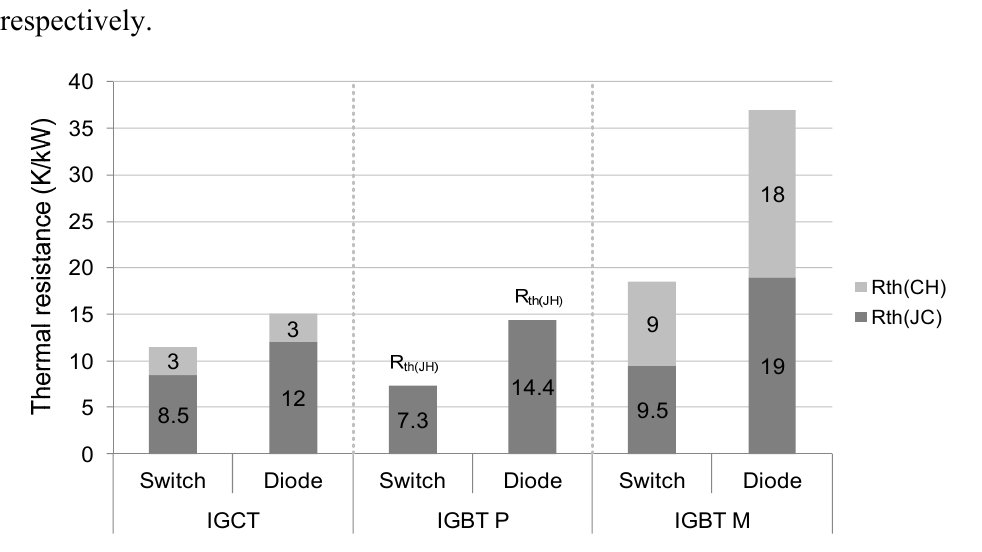
Figure 7. Thermal resistance from junction to heat sink for different power